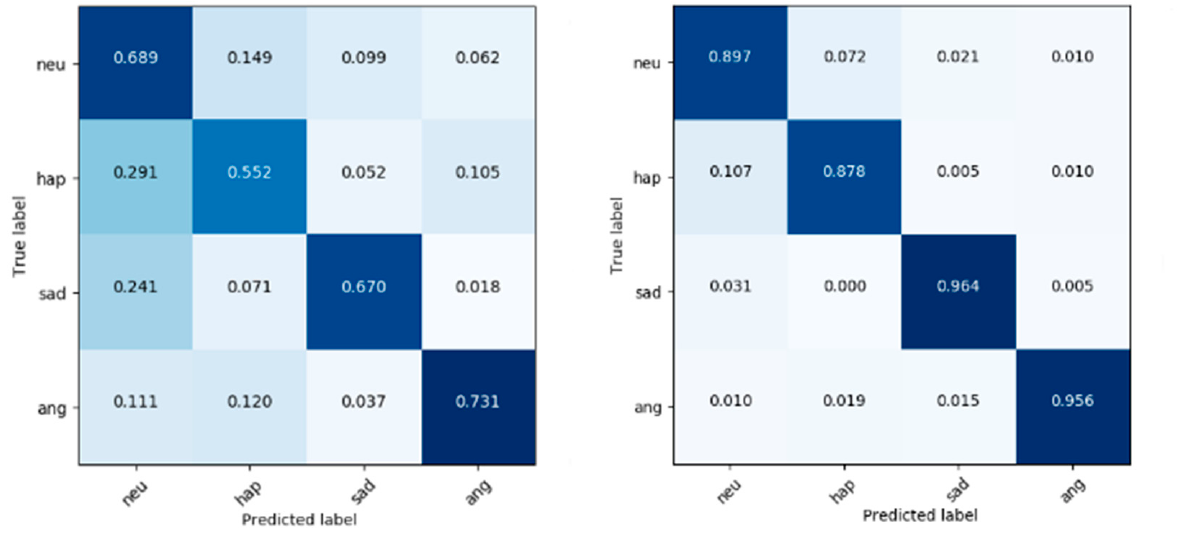
Figure 11. Confusion matrix for IEMOCAP and CHSE-DB Dataset.